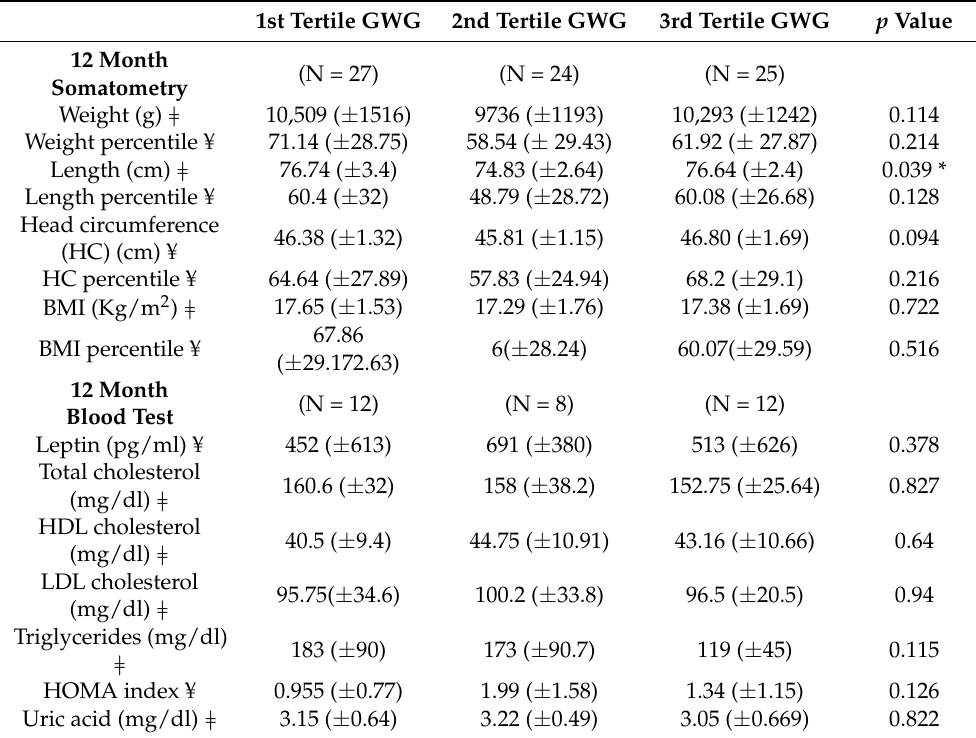
Table 3. Characteristics of children at 12 months of life according to tertiles of absolute maternal GWG. Data are presented as either mean ± SD. } Analysis of variance (ANOVA). ¥ The Kruskal Wallis test. Data with significant p -values are labeled as follows: * for p < 0.05. 1st Tertile